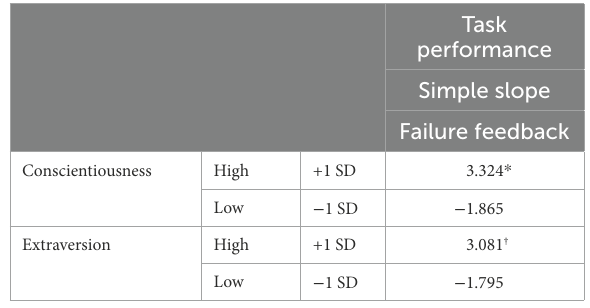
TABLE 3 Results from conditional effects